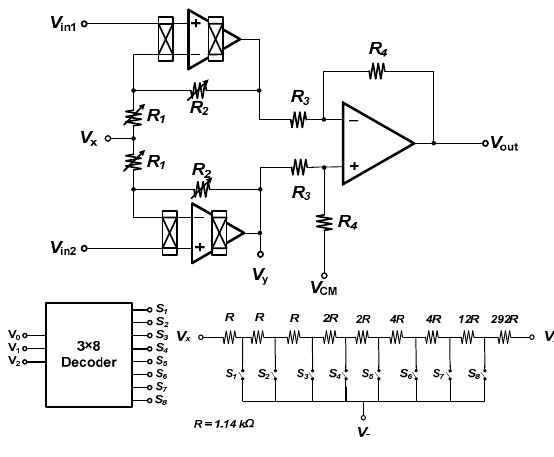
Figure 2. Tunable gain chopper IA [9].